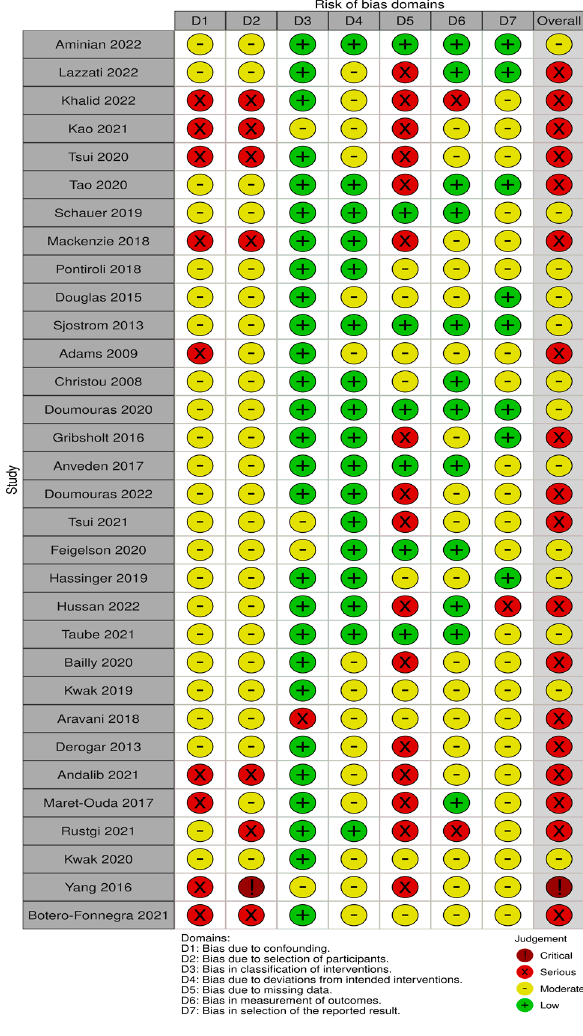
Figure 2. Risk of bias assessment in 32 studies based on 7 domains